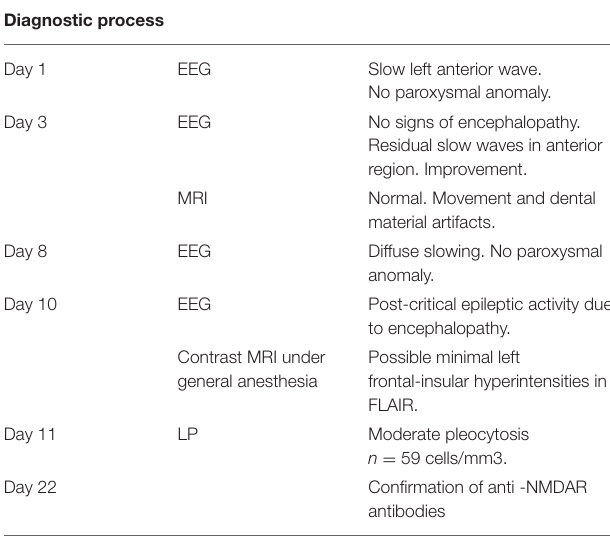
TABLE 1 | Summarizes the diagnostic process in a chronological order. Diagnostic